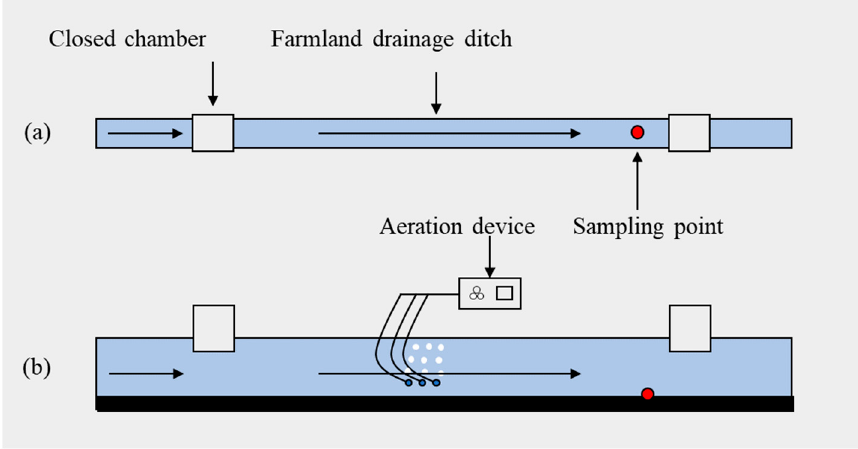
Figure 1. Layout of the experiment. ( a ) static box layout diagram; ( b ) aeration position